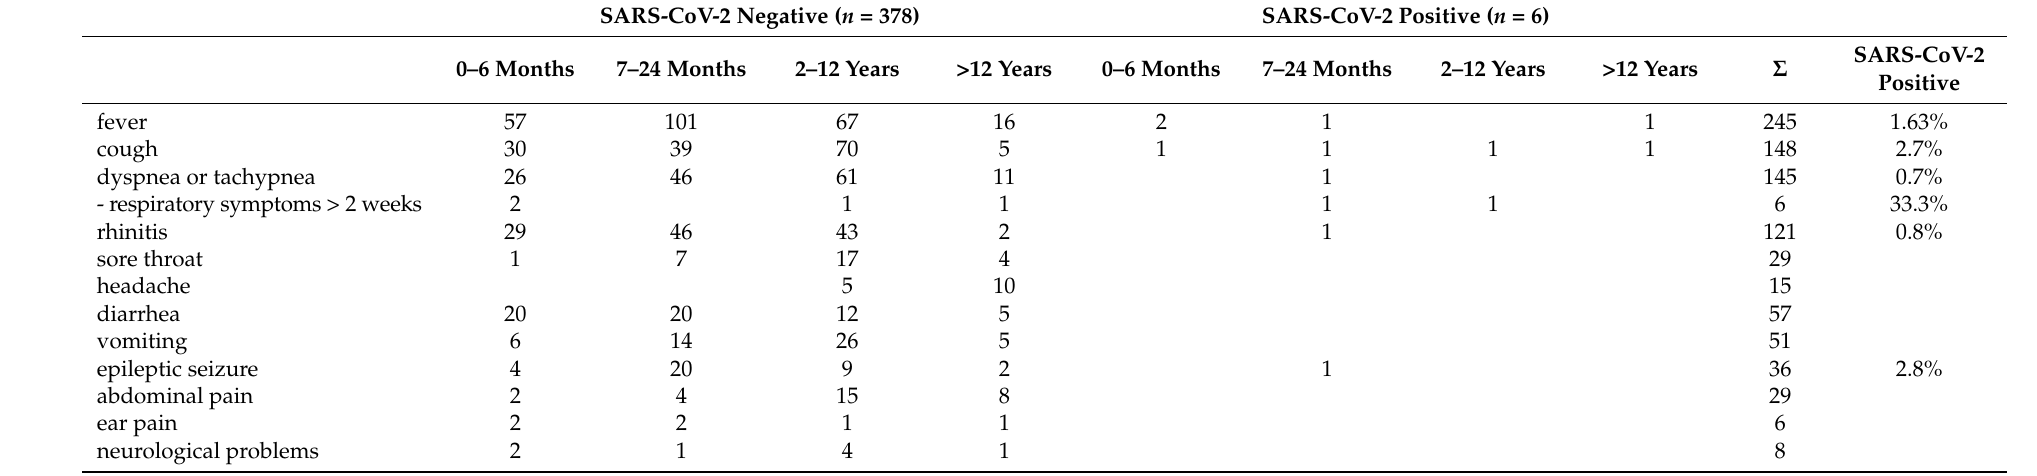
Table 3. Initial clinical presentation of children tested for SARS-CoV-2 upon clinical suspicion in different age groups (age in months [mo] or years [yrs] (Cohort